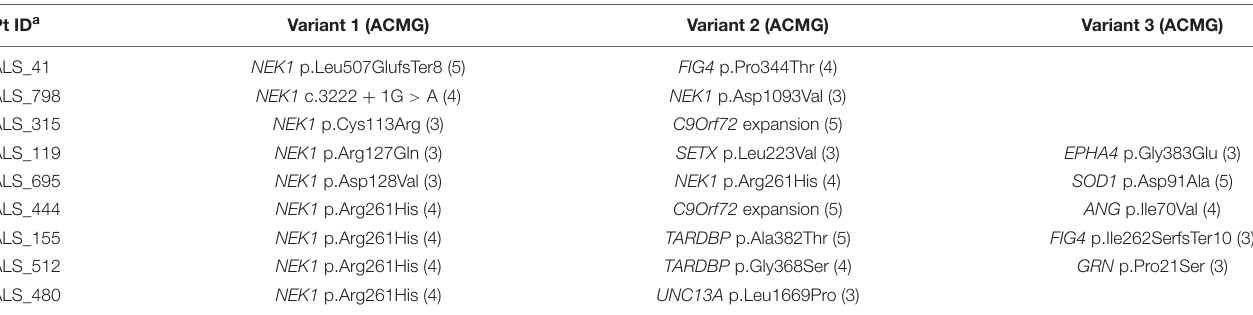
TABLE 3 | List of NEK1 carriers with other variants of interest.